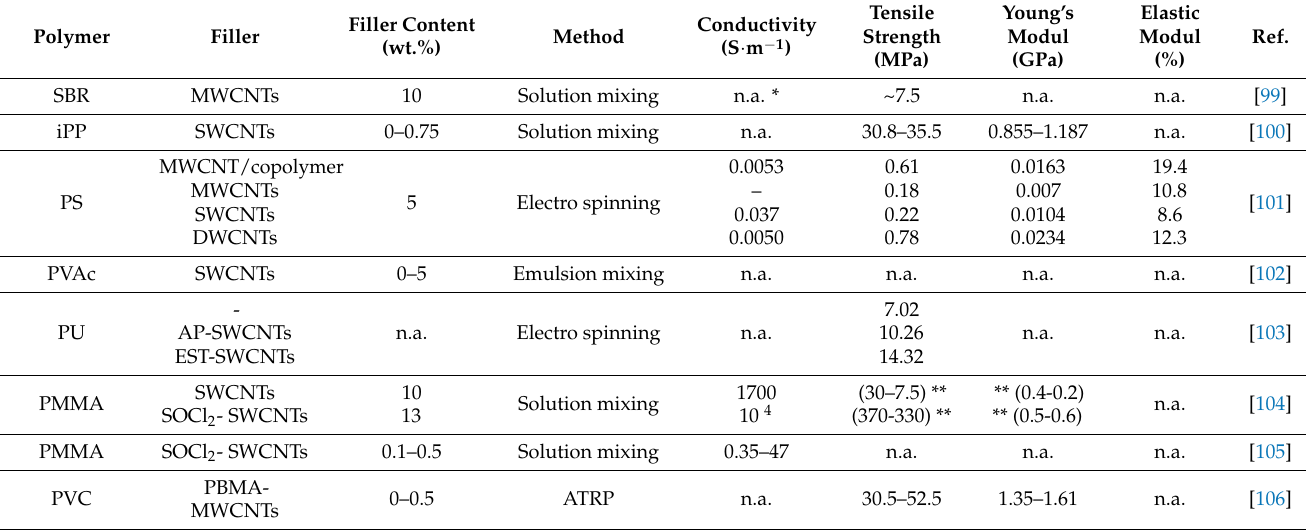
Table 4. Electrical conductivity and mechanical properties of CNTs/polymer nanocomposites. Filler Content Polymer Filler